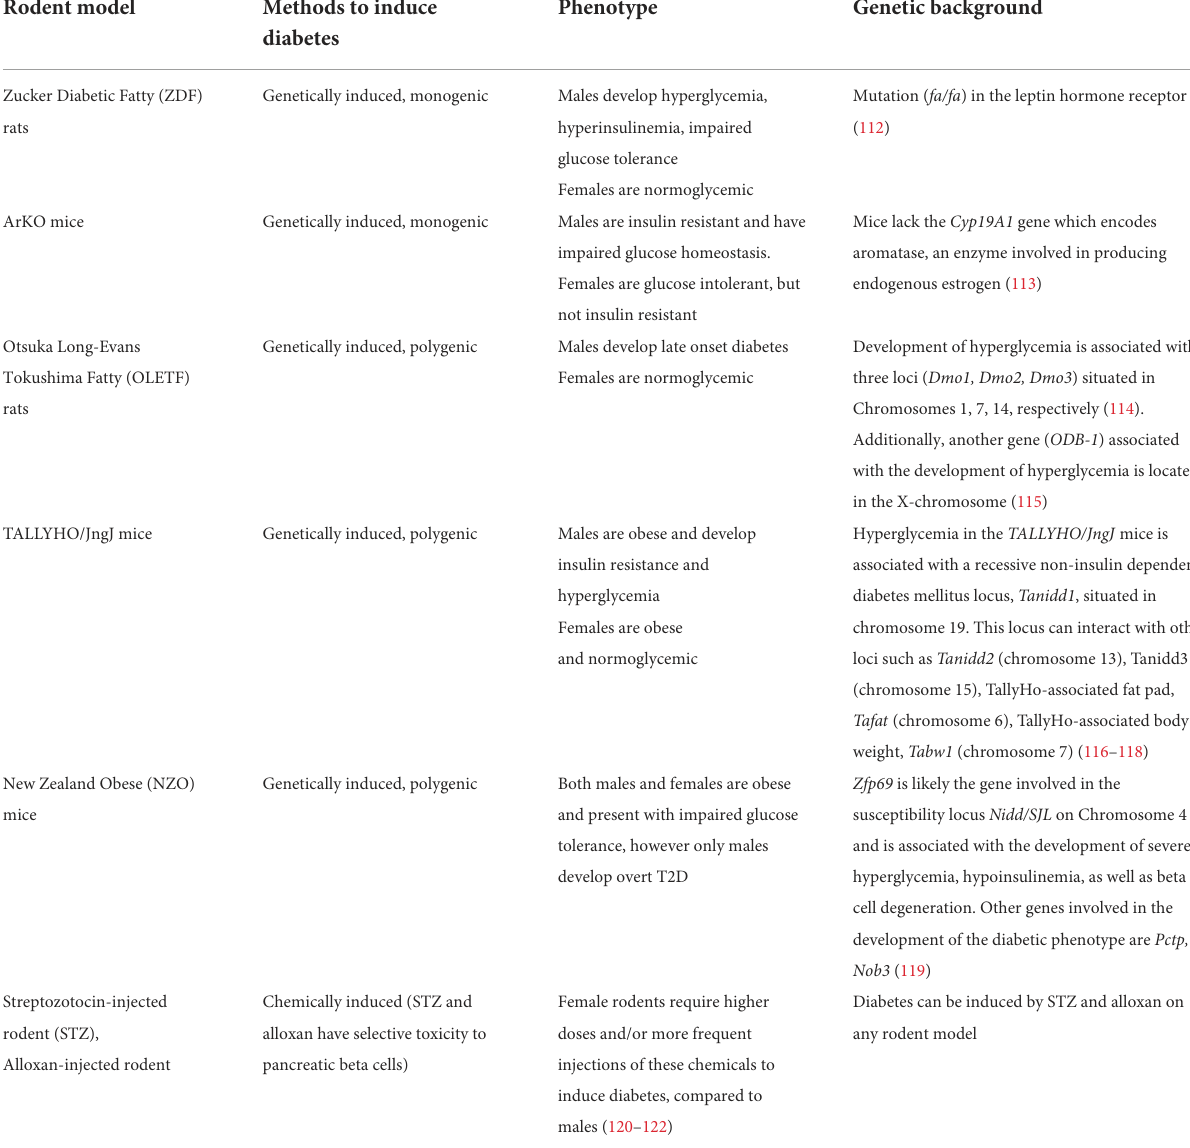
TABLE 4 Genetically and chemically induced rodent models of T2D showing sexual dimorphism in glucose homeostasis. Rodent